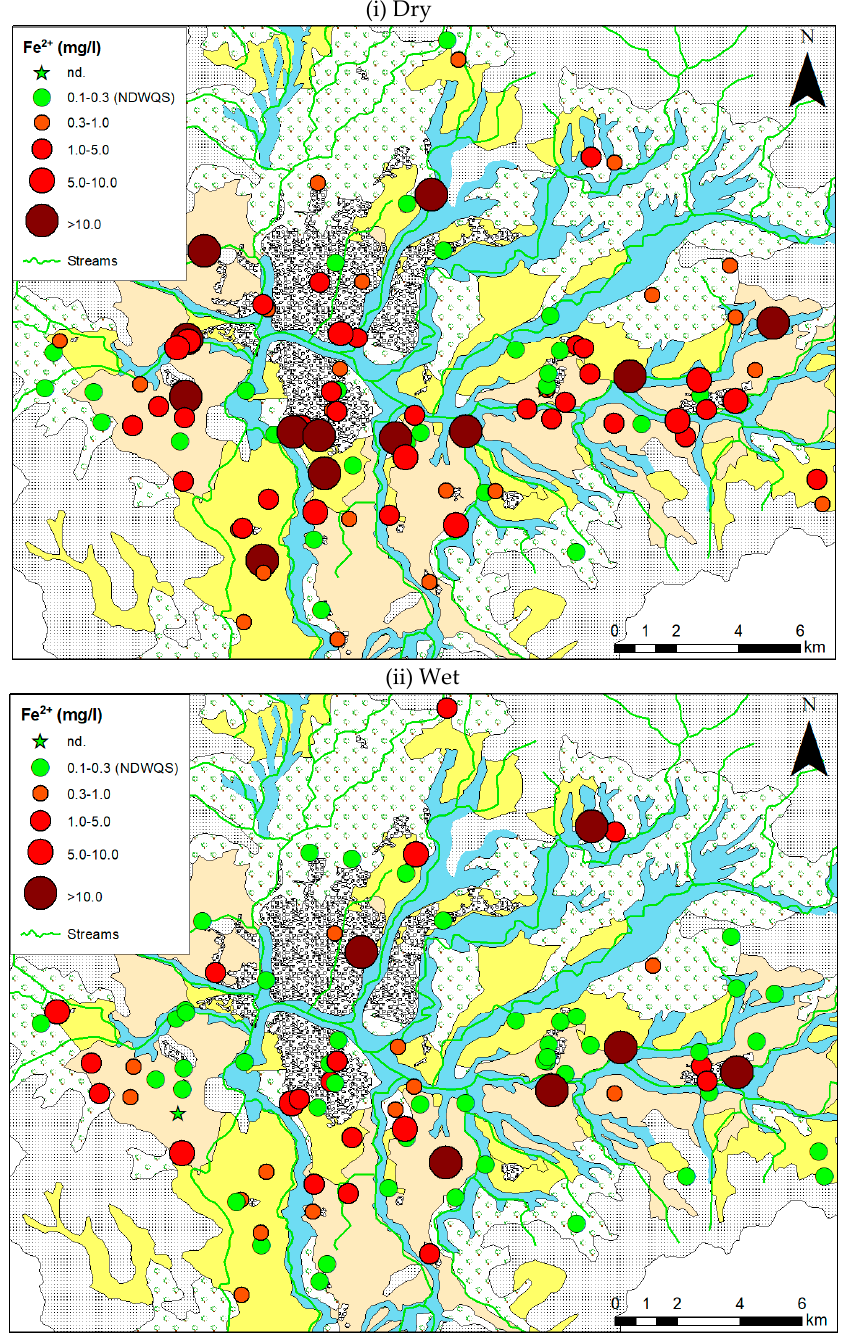
Figure 2. Spatial distributions of chemical concentrations from the sampled shallow dug wells in Kathmandu Valley: ( a ) NH 4 -N (mg-N/L), ( b ) NO 3 -N (mg-N/L), and ( c ) Fe 2+ (mg/L).